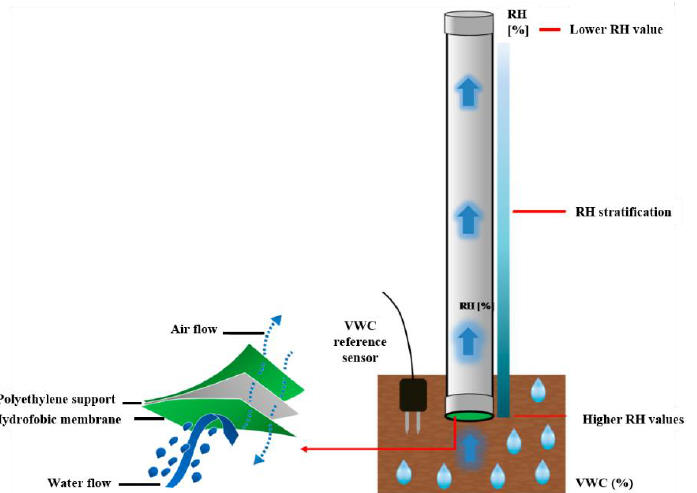
Figure 3. Operation principle of the optimized version of the fiber-optic sensor for soil moisture monitoring (from Ref. [53]).